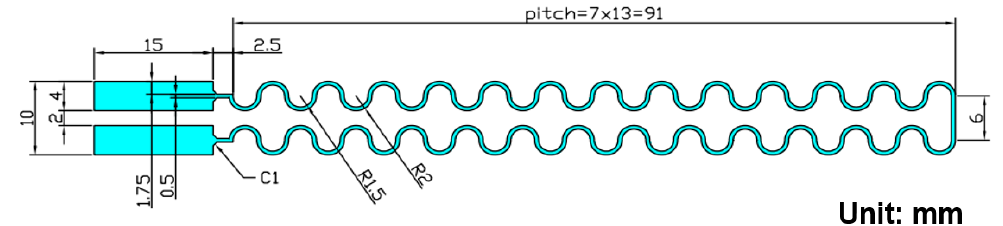
Figure 11. Pattern layout of test specimen for demonstrating the rollable function of the measurement platform.